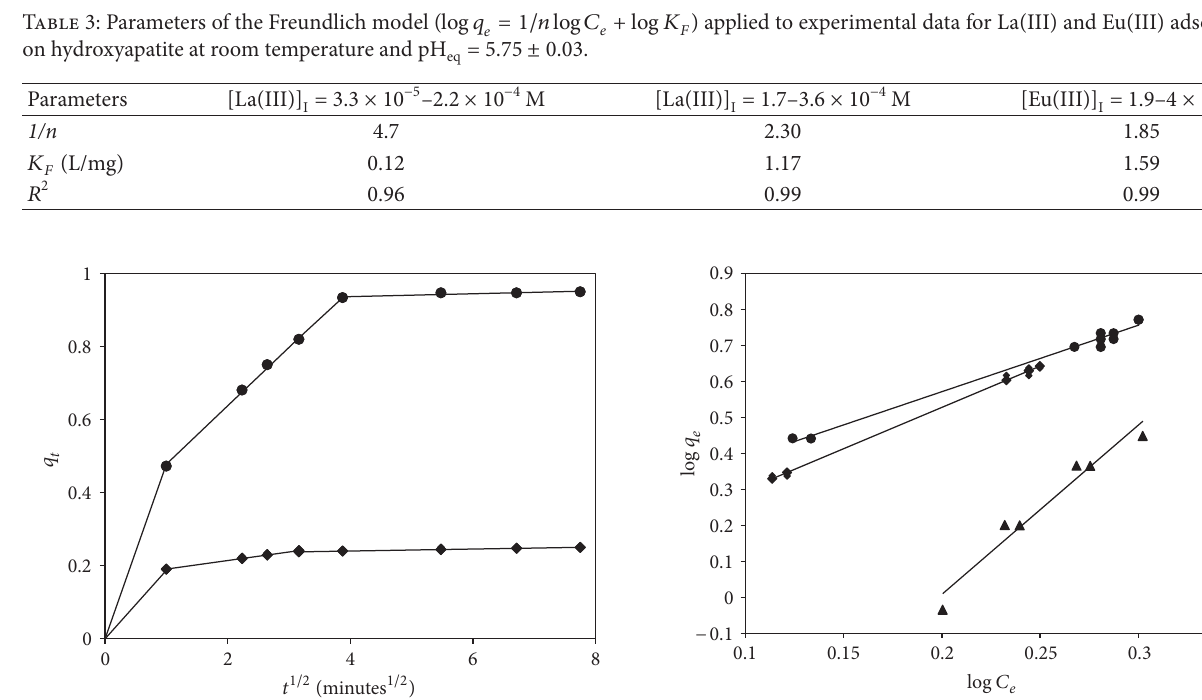
F 4: Amount of REEs adsorbed on synthetic hydroxyapatite ) and �tting of data to the intraparticle mass transfer diffusion 𝑞𝑞 𝑡𝑡